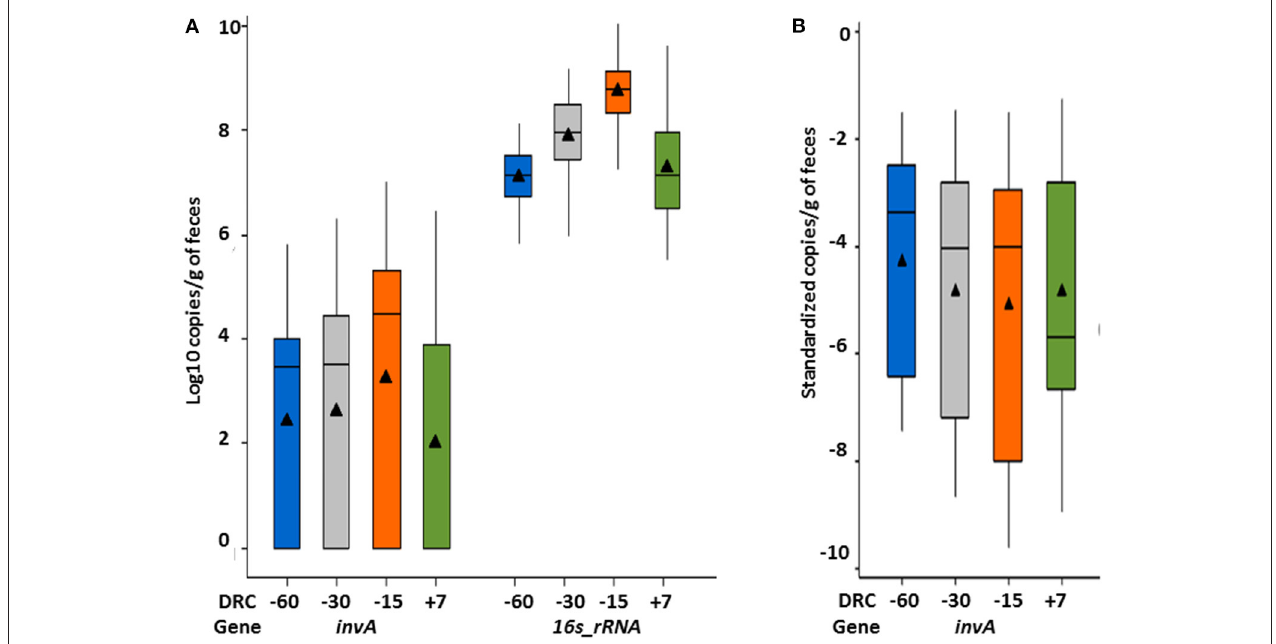
FIGURE 3 | Whisker box plot representing temporal variations of (A) Salmonella ( inv A gene) and 16s rRNA fecal concentrations; and (B) inv A standardized concentrations relative to total fecal bacterial quantification ( 16s_ rRNA gene) during the periparturient period. Mean (solid triangle), median (horizontal line), quartiles, and highest/lowest observations are represented in each